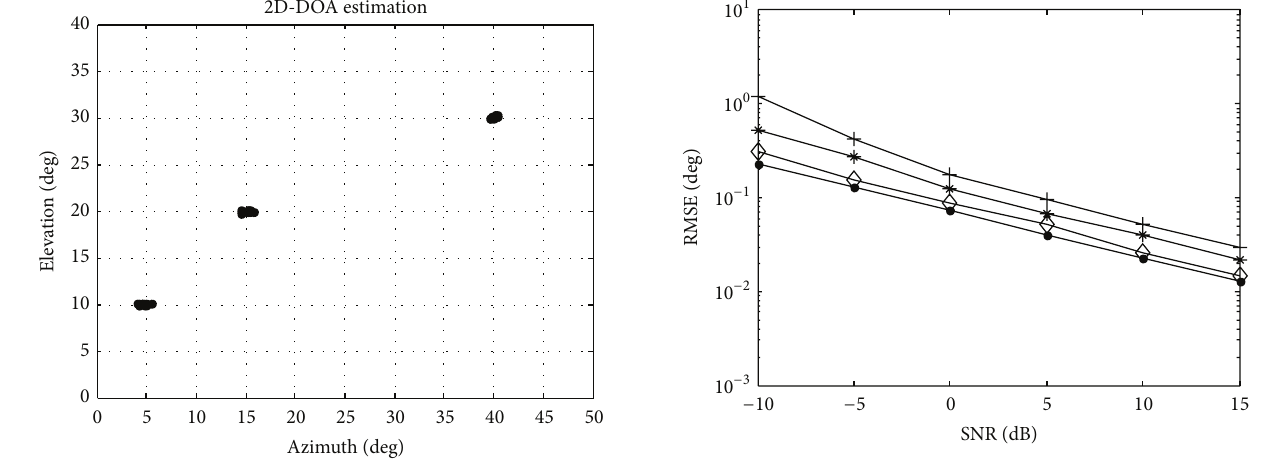
Figure 4: 2D-DOA estimation of our algorithm in SNR = −10 dB ( 𝑁 = 20 , 𝑀 = 16 , 𝐿 = 100 , and 𝐾 = 3 ).